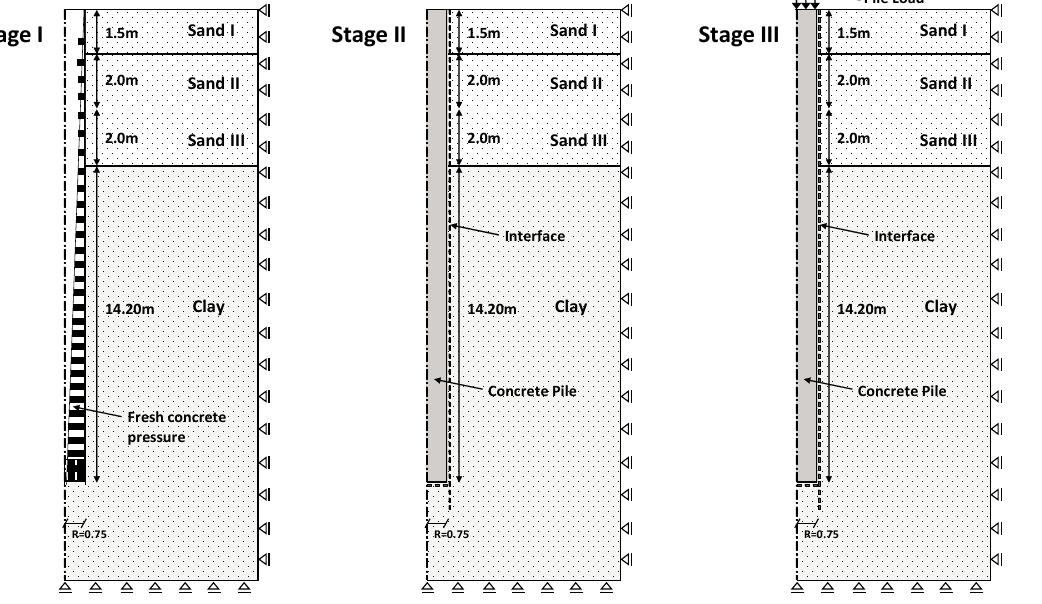
Fig. 5. Installation and load stages in numerical modelling of